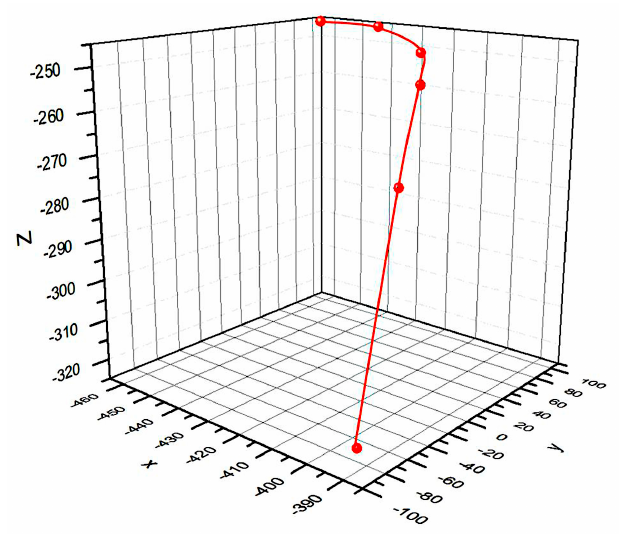
Figure 11. End three-dimensional path map.